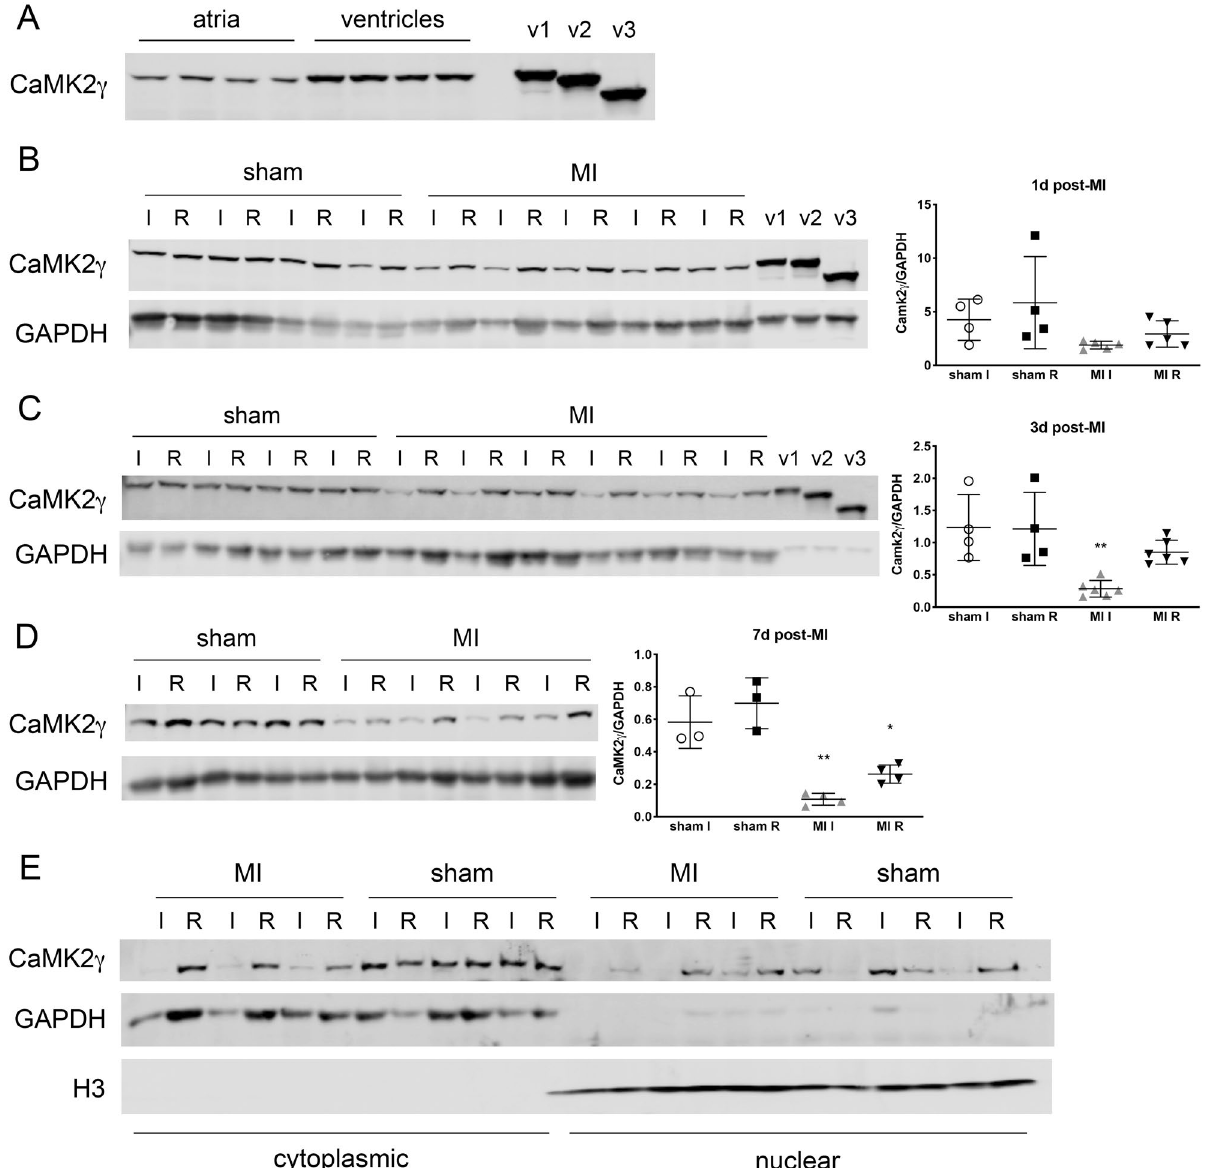
Figure 4. Sustained loss of CaMK2γ v1 expression in WT hearts 1 week post-MI. ( A ) CaMK2γ variant protein expression in naïve WT atria and ventricles. n = 4 mice. Recombinant proteins for each CaMK2γ variant were used to confirm identities of each isoform. ( B – D ) Western blotting for CaMK2γ splice variants in WT hearts at 1 day ( B ), 3 days ( C ) and 7 days post-MI ( D ). n = 3–6 for each time point. Cropped blots shown, with GAPDH used for loading control and normalization, with quantification graphs to the right of the blots. For B–D, overall p -values were p = 0.10, p = 0.0017 and p < 0.0001, respectively, using one-way ANOVA with Tukey’s multiple comparisons. * p < 0.05, ** p < 0.01 for between group comparisons. p -values are for MI I (or MI R) vs. all other groups. ( E ) Western blots of CaMK2γ expression in cytoplasmic and nuclear fractions of WT heart tissue 3 days post-MI. GAPDH denotes cytoplasmic portion while histone H3 was used to identify the nuclear fraction. n = 3 per group. I = ischemic tissue, R = remote. Uncropped western blots shown in Supplementary Fig.